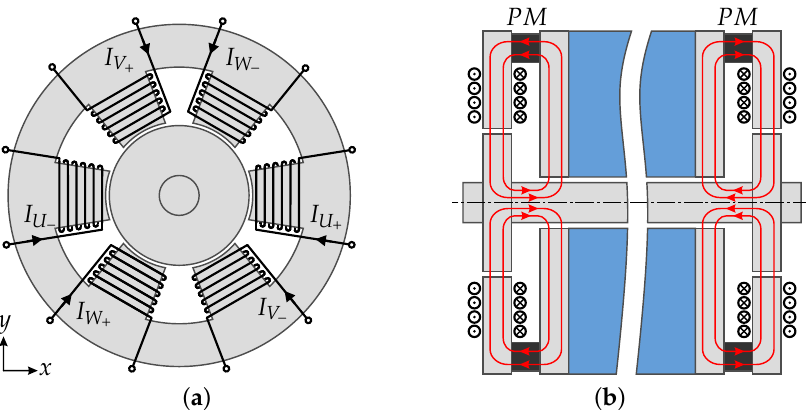
Figure 1. ( a ) Structural design of the six pole radial homopolar active magnetic bearing. ( b ) Cross section of the shaft: The bias flux (indicated by red lines) is generated by means of permanent magnets.